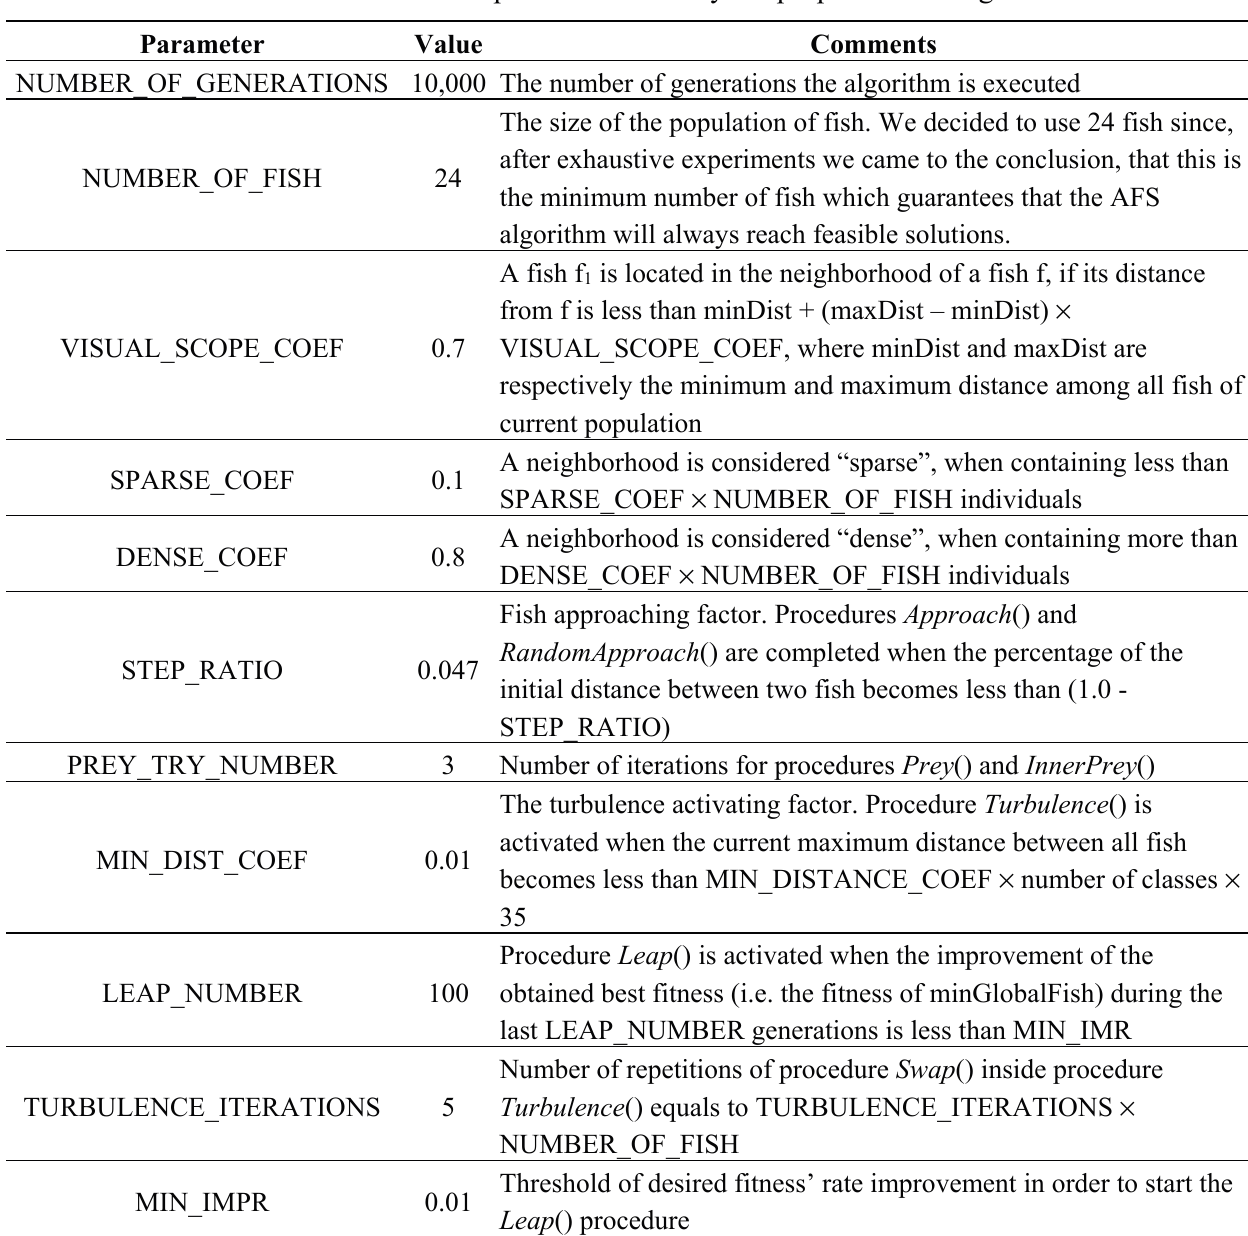
Table 1. The user defined parameters used by the proposed AFS algorithm.